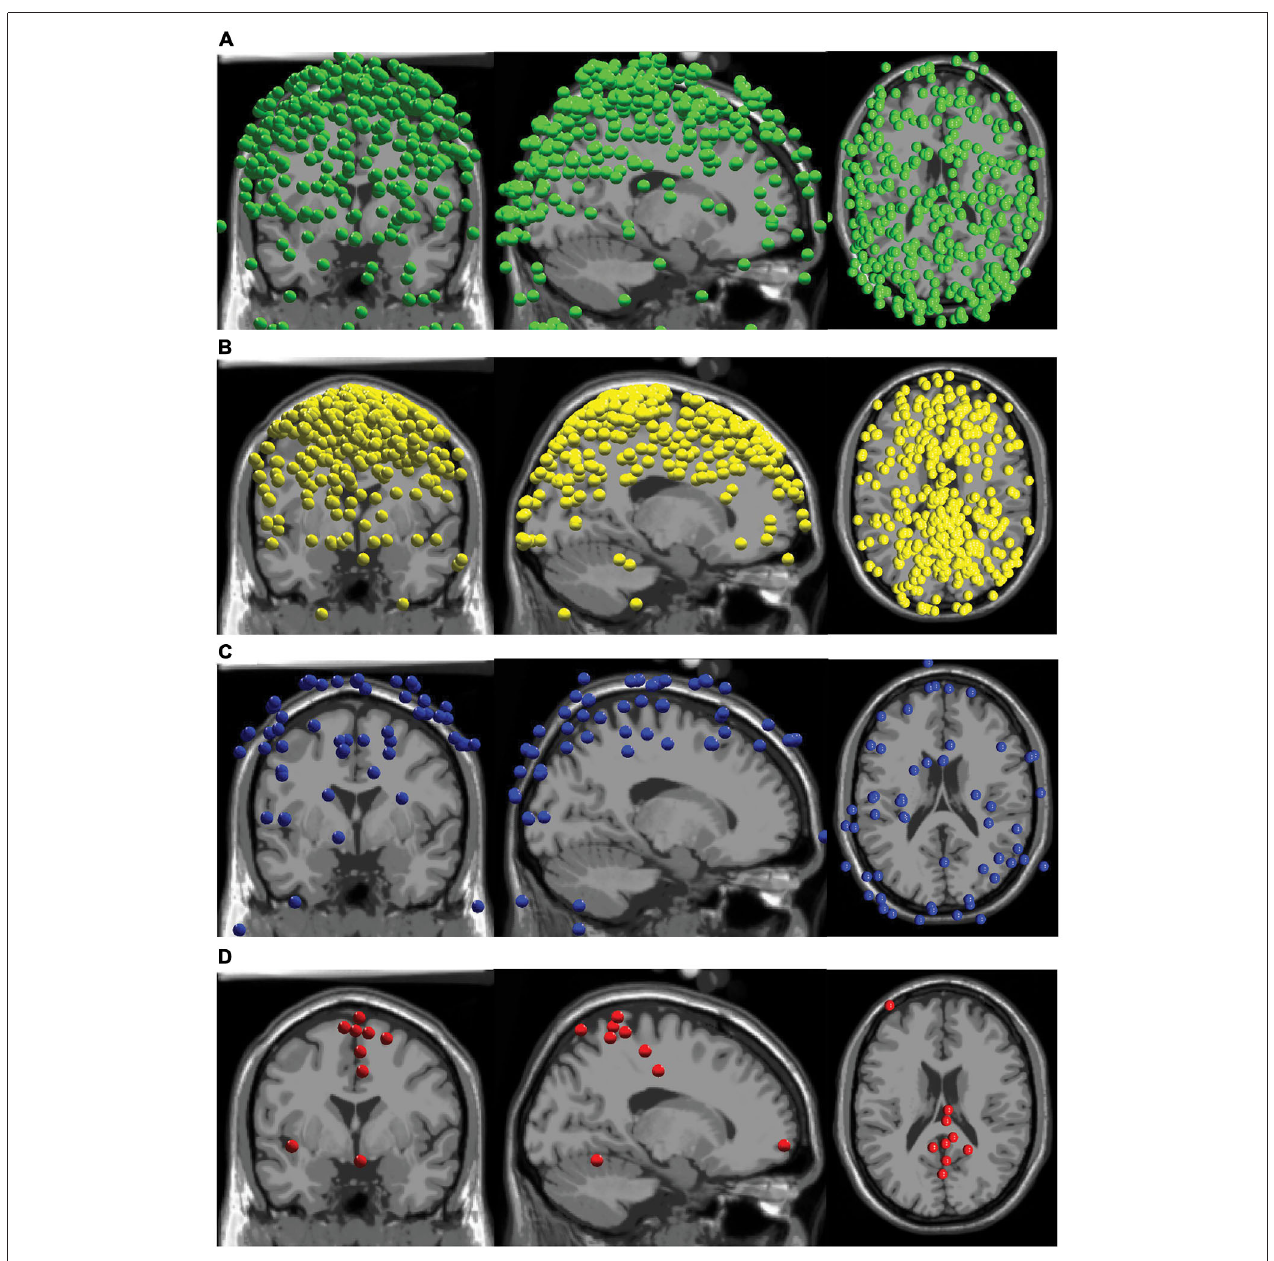
FIGURE 2 | Component locations. (A) All components with RVs > 15% with locations outside the brain are shown in green. (B) All components with RVs > 15% with locations inside the brain are shown in yellow. (C) All components with RVs < 15% with locations outside the brain are shown in blue. (D) All components with RVs < 15% with locations inside the brain are shown in